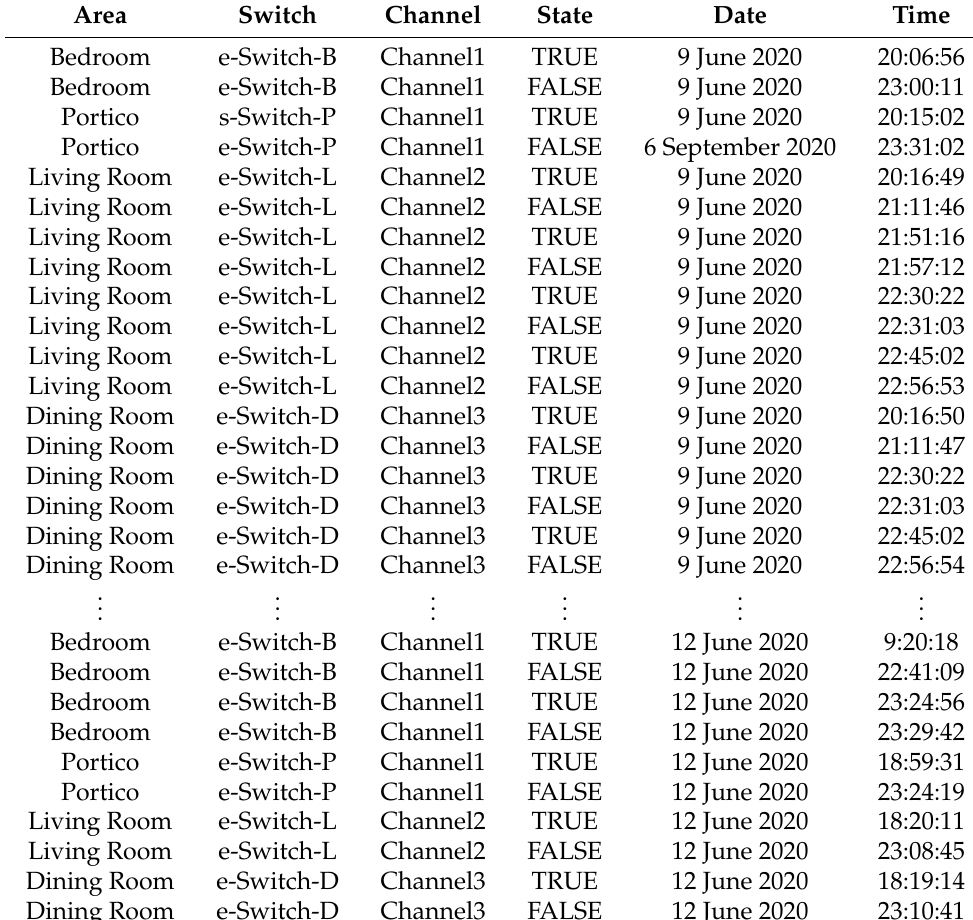
Table 3. Platform register